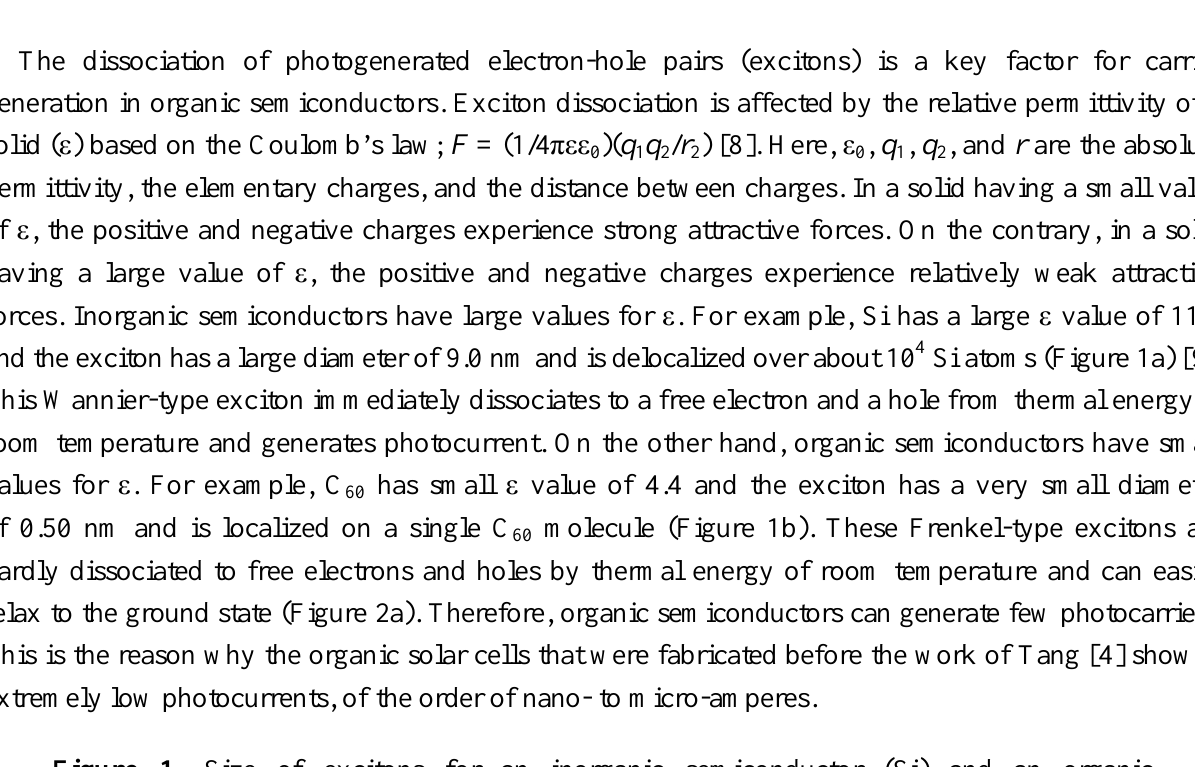
Figure 1. Size of excitons for an inorganic semiconductor (Si) and an organic ). The former is Wannier-type and easily dissociates to free carriers. semiconductor (C 60 The latter is Frenkel-type and hardly dissociates to free